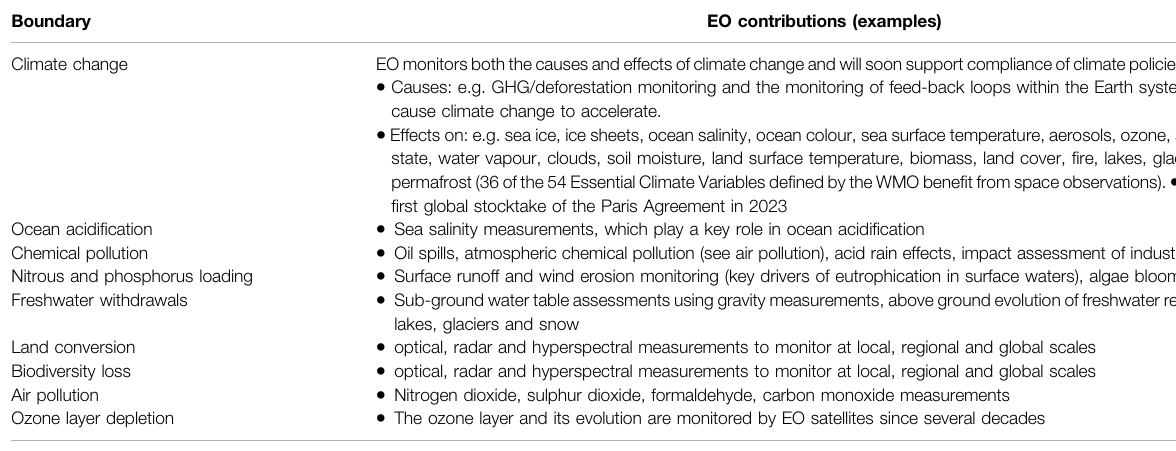
TABLE 2 | Relevance of EO data and information for assessing the parameters of the Doughnut economics model (authors ’ assessment). Ecological